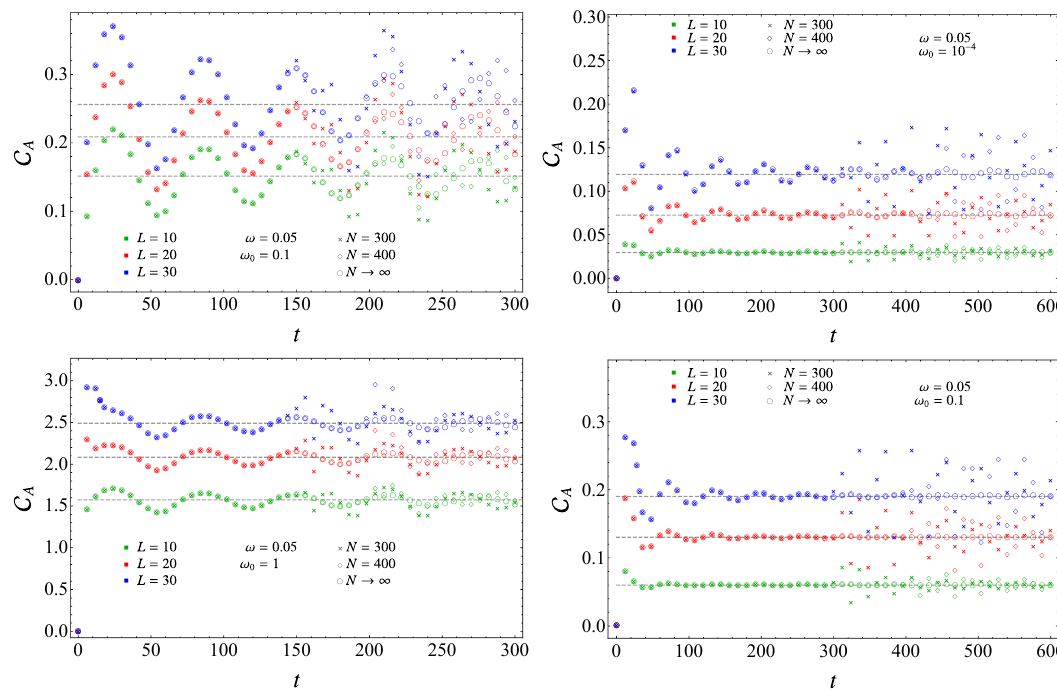
Figure 20 . Temporal evolution of C A after a global quantum quench with a gapped evolution Hamiltonian. In the left panels the chains are either on the circle or on the infinite line, while in the right panels the chains are either on the segment or on the semi-infinite line with DBC and A is adjacent to a boundary. The dashed grey lines correspond to